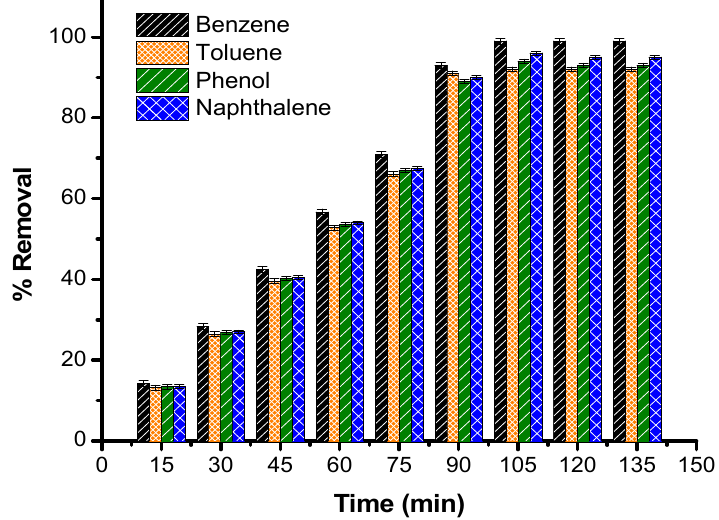
Figure 6. Effect of reaction time on the removal of HCs over AC from model wastewater (35 °C, adsorbent dose 600 mg/100 mL model wastewater).